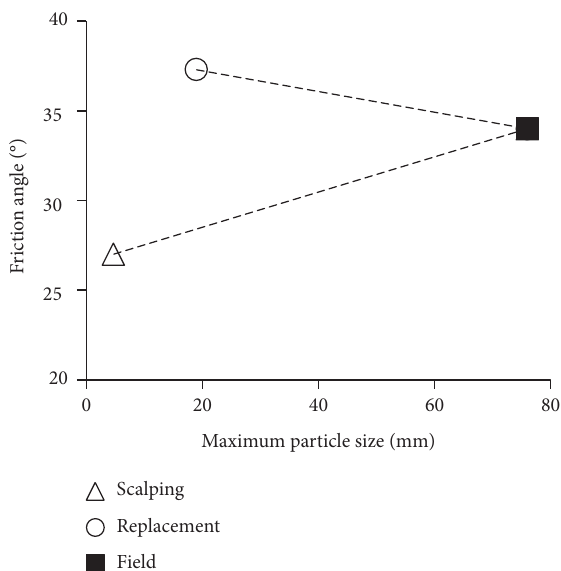
Figure 10: Comparison of friction angles of scalped and replaced samples with that of the field sample, all having a gravel content of 60% (data taken from